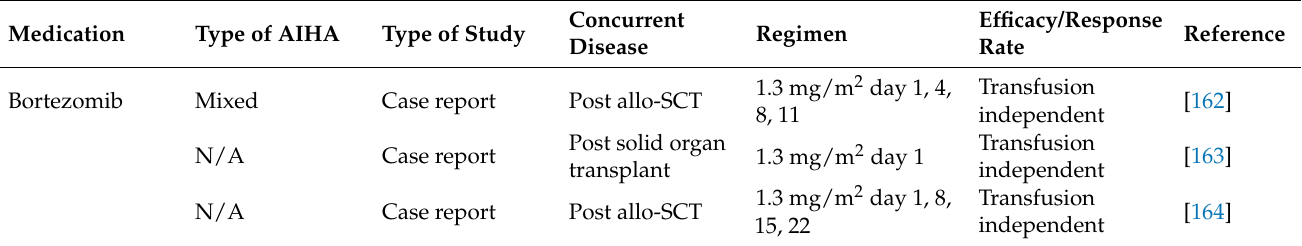
Table 2. Plasma cell-directed